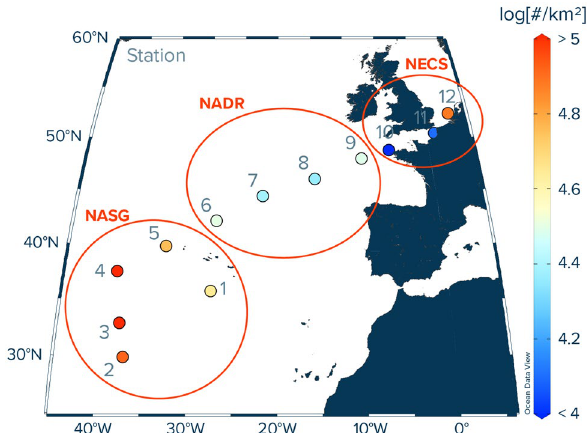
Figure 1. Locations of study sites in the eastern North Atlantic Ocean and associated measured numerical concentrations of floating plastic debris [#/km 2 ] at the ocean surface (debris size: 500 µm to 5 cm in size). The numbers 1–12 correspond to the station numbers. Note that the numerical concentrations shown here represent average values of three Manta trawl deployments per station. All values were corrected for wind-induced mixing (see Supplementary Information for calculations). NASG North Pacific Subtropical Gyre, NADR North Atlantic Drift Region, NECS Northeast Atlantic Continental Shelves. The map was created using Ocean Data View (version 5.5.2; https:// odv. awi.